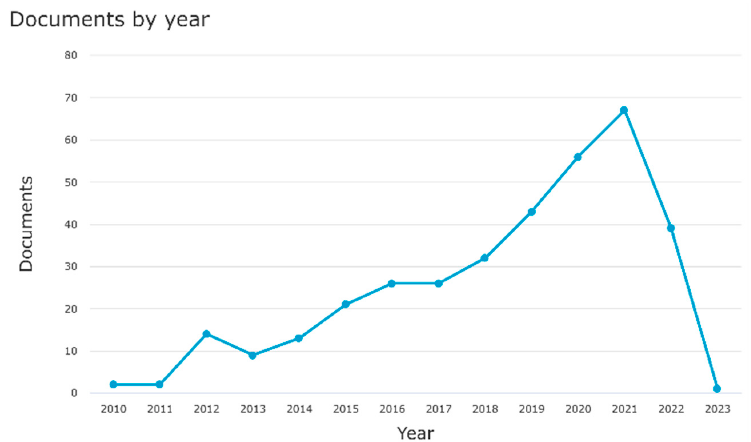
Figure 37. Publication per year on iOBC for electric vehicles from 2010 to until 2022.